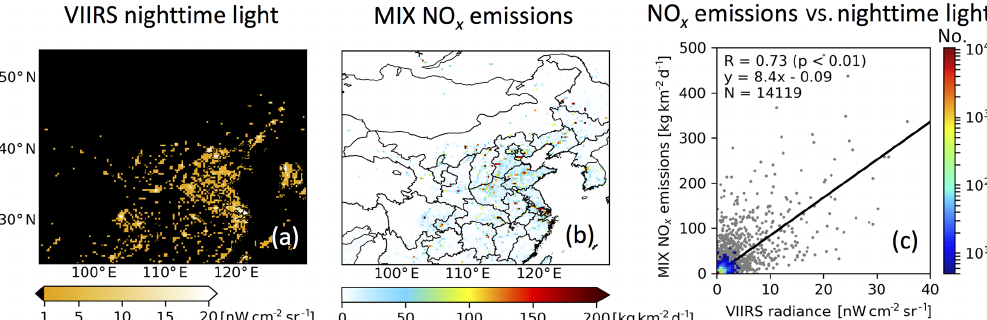
Figure 3. Panels (a) and (b) show VIIRS nighttime light radiance and MIX NO x emissions at 0 . 25 ◦ × 0 . 25 ◦ resolution in April 2018 and April 2010, respectively. Panel (c) shows a scatter plot of MIX NO x emissions versus VIIRS nighttime light radiance (grid cells with VIIRS nighttime light radiance less than 0.1nWcm − 2 sr − 1 are removed). Table 1. Design of experiments for simulating surface SO 2 and NO 2 concentrations over China in October 2013. Experimental Model SO 2 NO x Downscaling Downscaling Sfc. SO 2 Sfc. NO 2 name a resolution emissions emissions sfc. SO 2 conc. sfc. NO 2 conc. resolution resolution